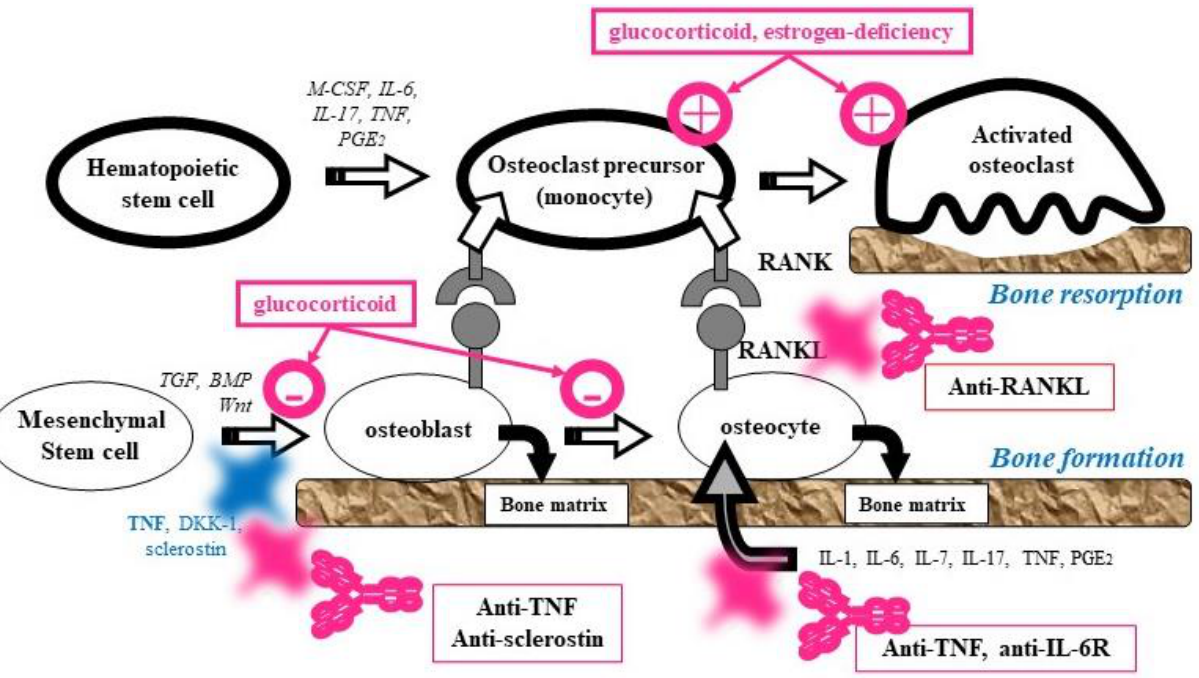
Figure 1. Bone formation and resorption. Osteoblasts and osteocytes differentiate from mesenchymal stem cells to produce bone matrix. Osteoclasts derived from hematopoietic stem cells mature to multinucleated osteoclasts in response to stimulation by RANKL expressed in osteoblasts and osteocytes.